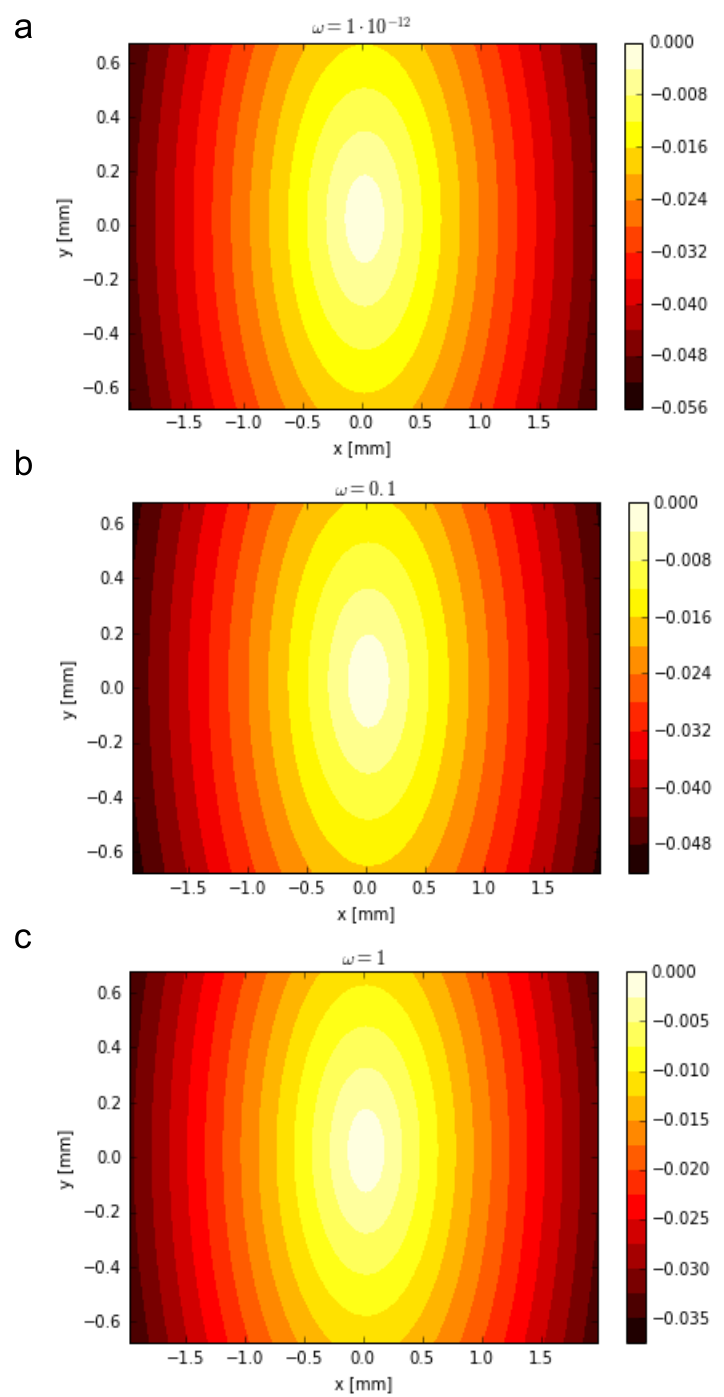
Figure 5. ( a ) Variation of the lateral contraction as a function of the distance r (from the center of the cross section) for a longitudinal strain of 0.05 and ω = 1 × 10 − 12 . ( b ) Variation of the lateral contraction as a function of the distance r (from the center of the cross section) for a longitudinal strain of 0.05 and ω = 0.1. ( c ) Variation of the lateral contraction as a function of the distance r (from the center of the cross section) for a longitudinal strain of 0.05 and ω =